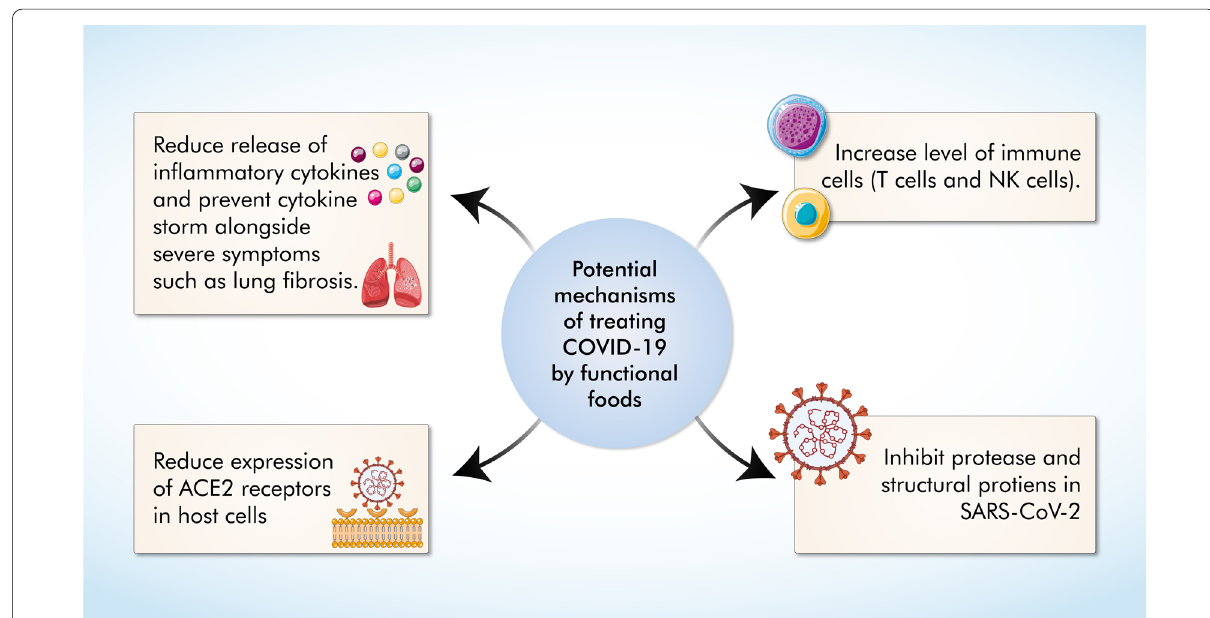
Fig. 3 Proposed mechanisms of COVID-19 treatment by functional foods. Functional foods can alleviate COVID-19 symptoms through their immunomodulatory and antiviral properties. Preventing cytokine storms, elevating numbers of immune cells (T cells & NK cells), reducing ACE2 receptor expression, and inhibiting viral replication through inhibition of viral proteins and enzymes are some of the ways through which functional foods can help improve COVID-19